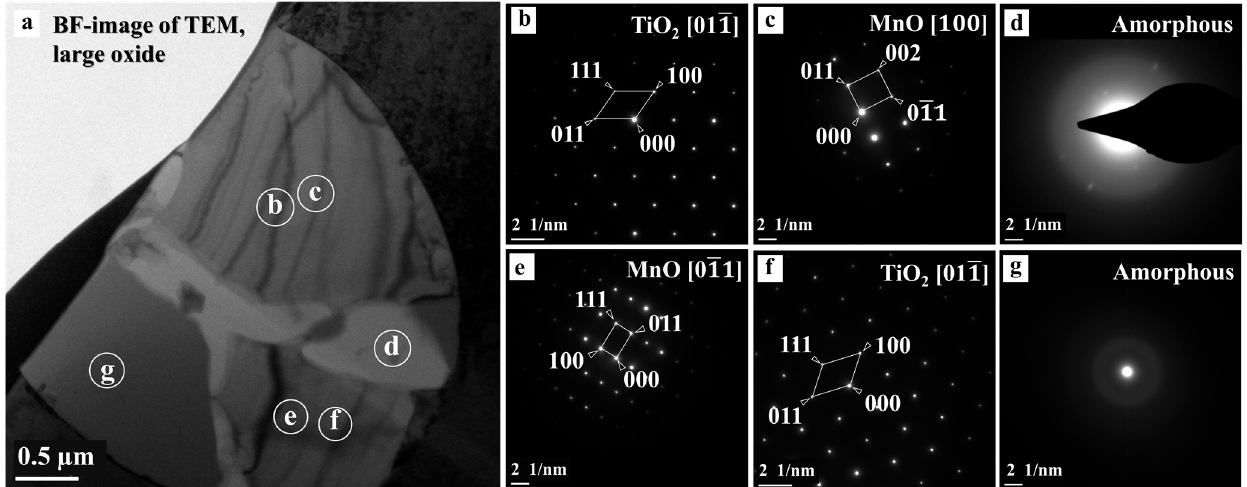
Figure 4. TEM images corresponding to large oxide inclusions: ( a ) BF-image with selected areas for diffraction patterns; ( b ) SADP of TiO 2 ; ( c ) SADP of MnO; ( d ) SADP of amorphous; ( e ) SADP of MnO; ( f ) SADP of TiO 2 ; ( g ) and SADP of amorphous.